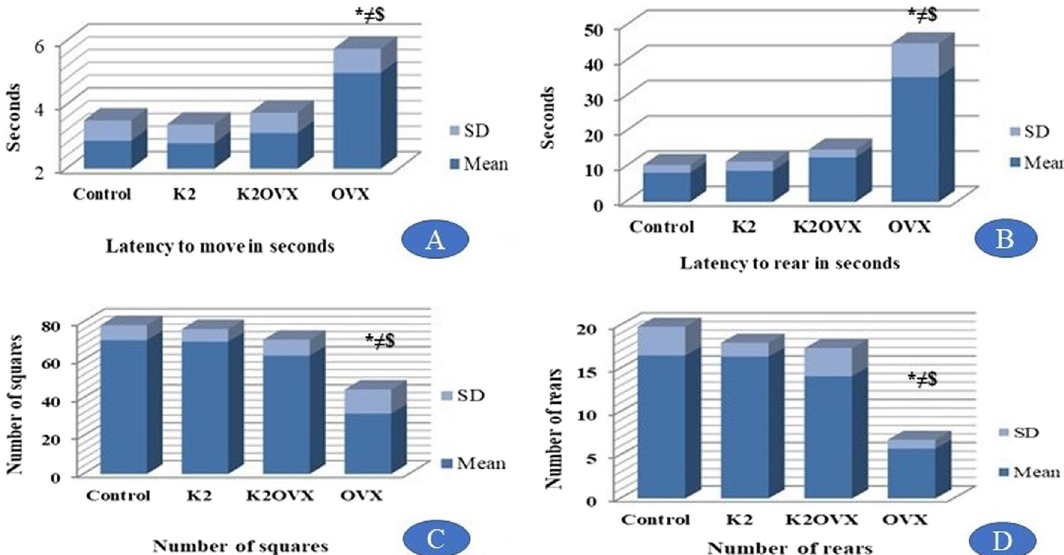
Fig. 2 A A histogram shows latency to move in seconds in all the studied groups, B A histogram shows latency to rear in seconds in all the studied groups, C A histogram shows number of squares entered in all the studied groups, and D A histogram shows number of rears in all the studied groups. * : Significant difference to control group, ≠ : Significant difference to K 2 group, and $: Significant difference to K 2 OVX